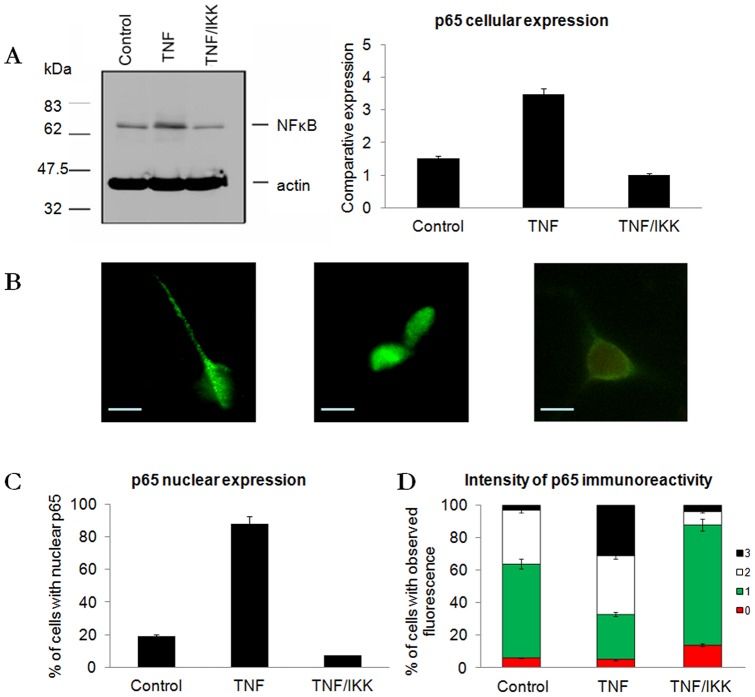
Immunofluorescent staining of primary cortical neurons.A: p65 expression in primary cortical neurons, showing increased expression with TNF-α and decreased expression with IKK Inhibitor (F = 177.79; p<0.001; df = 2,12). B: NF-κ B expression in a control neuron, using anti-p65 antibody and FITC labelled secondary, NF-κ B expression in a TNF-α stimulated neuron and NF-κ B expression in a TNF-α stimulated neuron with NF-κ B inhibitor. C: The percentage of neurons with anti-p65 staining in the nucleus (F = 30.63; p<0.001; df = 2,14), and D: the levels of fluorescence in each sample where fluorescence is rated between 0 and 3 on the scale bar (F = 17.65; p<0.002; df = 2,57). Molecular weight markers are in kilodaltons (kDa).